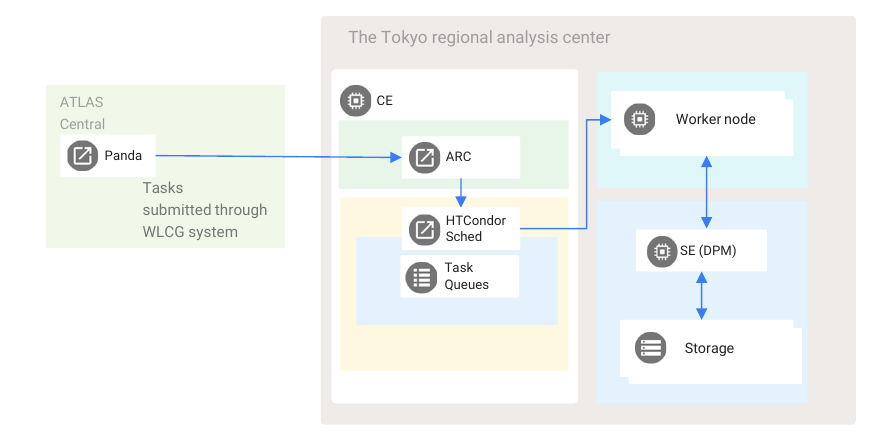
Figure 2. The schematic view of the current production workflow at the Tokyo regional